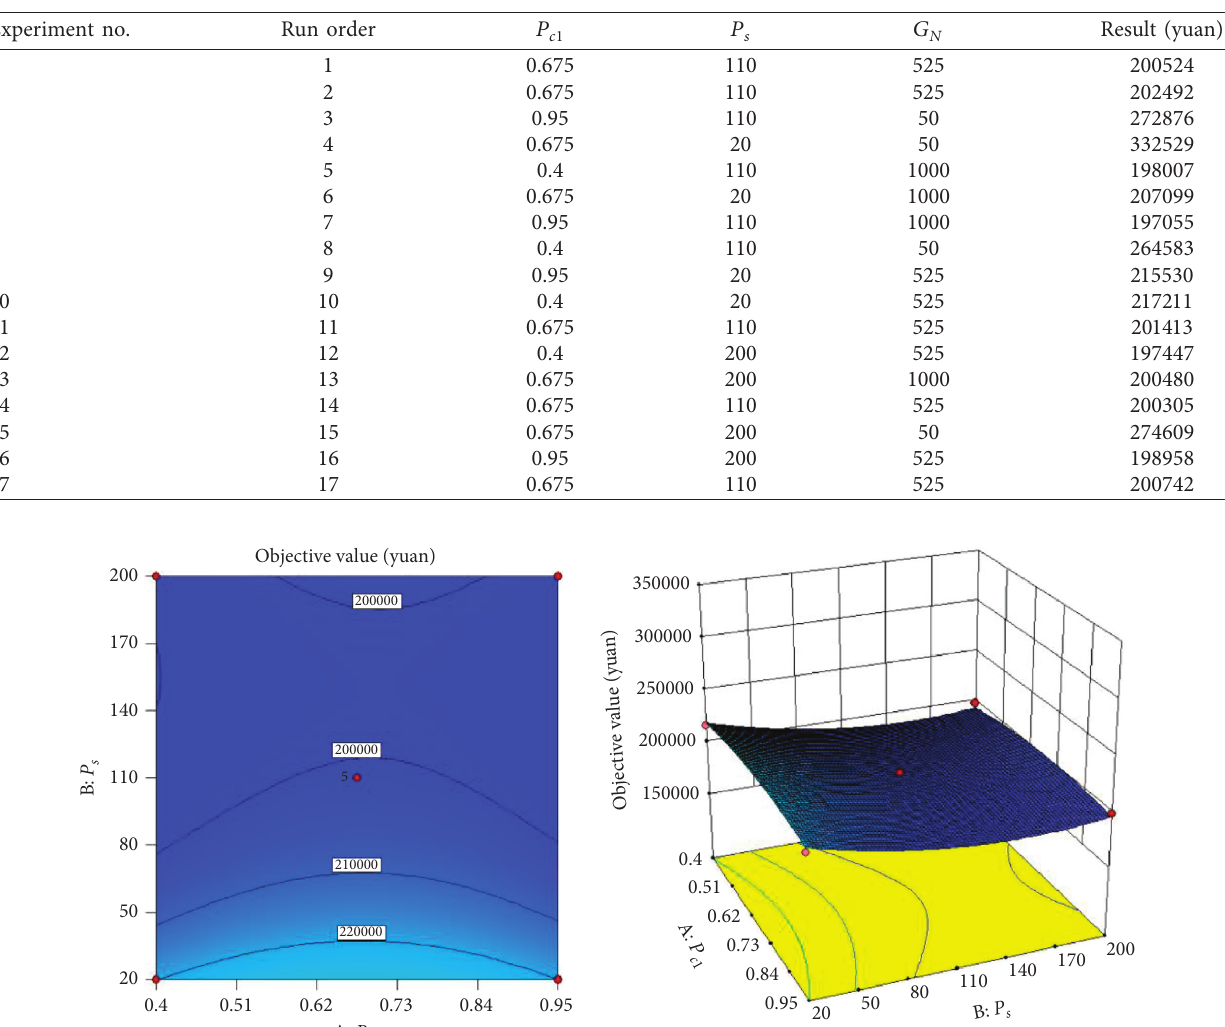
Table 12: Experiment design.